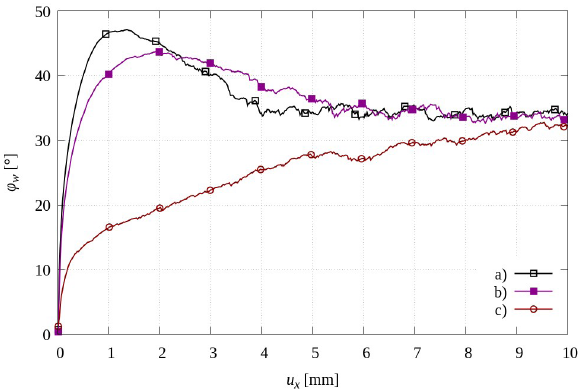
versus horizontal displacement w = 0.53, b) e = 0.60 and c) e = 0.75 (σ = 200 kPa, 0 0 0 0